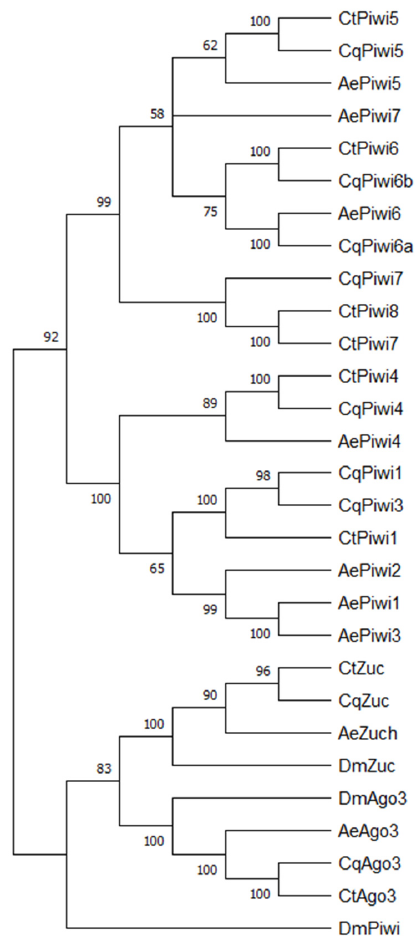
Figure 1. Phylogeny of Cx. quinquefasciatus, Cx. tarsalis, Ae. aegypti , and D. melanogaster PIWI family protein sequences. All amino acid sequences were aligned using the MUSCLE algorithm. A maximum likelihood tree was generated using the LG model with 500 bootstrap values. Accession numbers are listed in Supplementary Table S1.